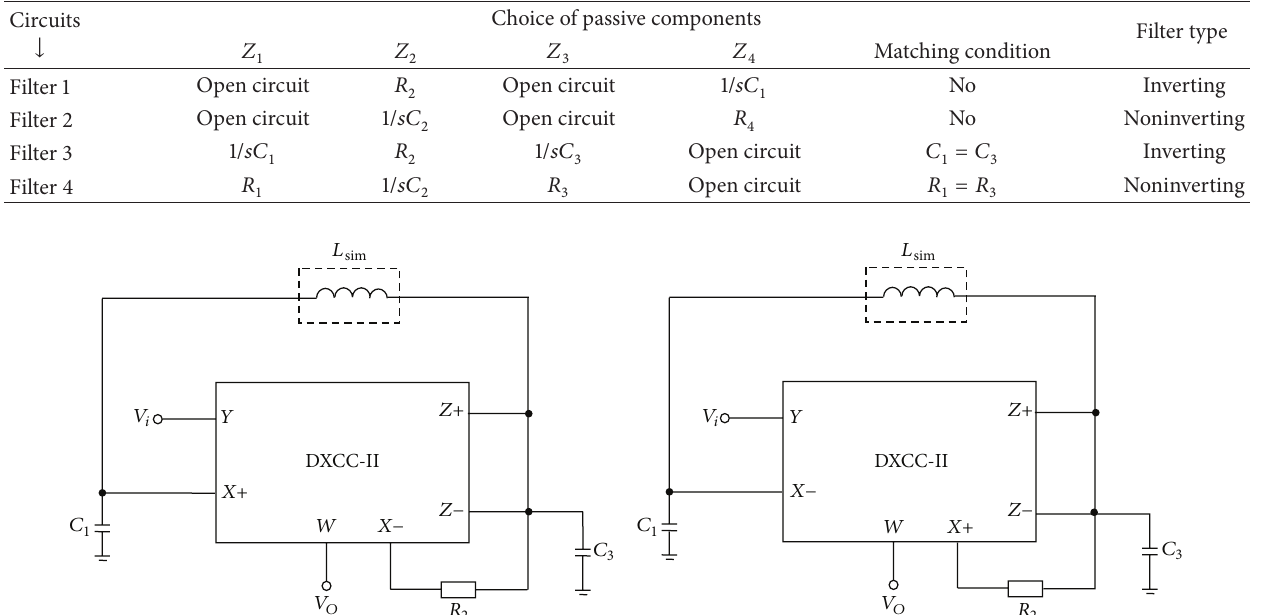
𝑍 = 1/𝑠𝐶 , resp .) 𝑍 3 3